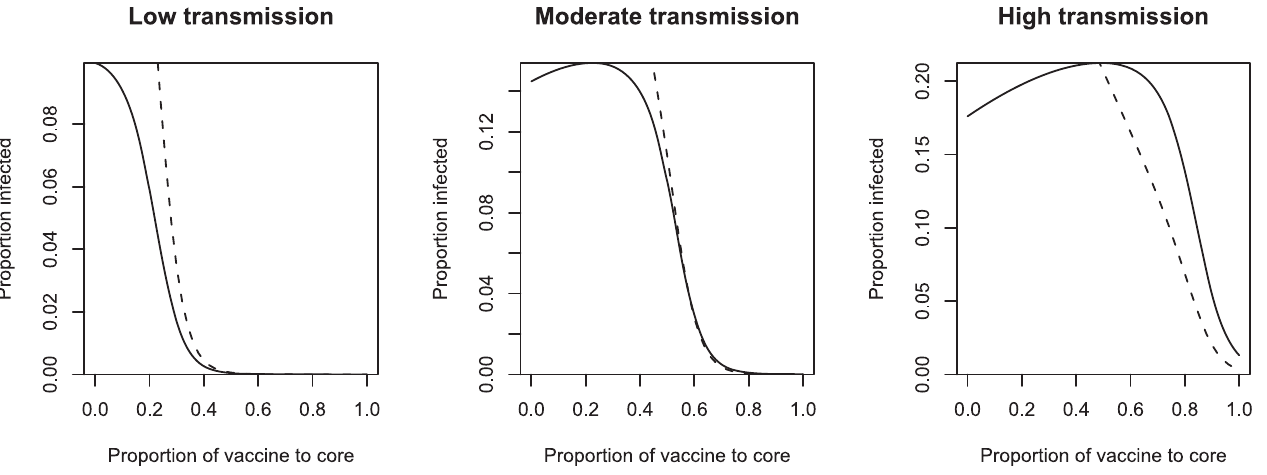
Figure 2. Vaccine Allocation Tradeoffs in a Population with Weak Assortative Mixing The proportion of ‘‘ vulnerable ’’ (solid lines), and ‘‘ core ’’ (dashed lines) individuals infected as a function of the proportion of vaccine given to core individuals, for three different transmission scenarios. Parameters are the same as in Figure 1, except that the coefficient of preferred mixing used is 0.1 (rather than 0.7). doi:10.1371/journal.pmed.0040174.g002 PLoS Medicine |